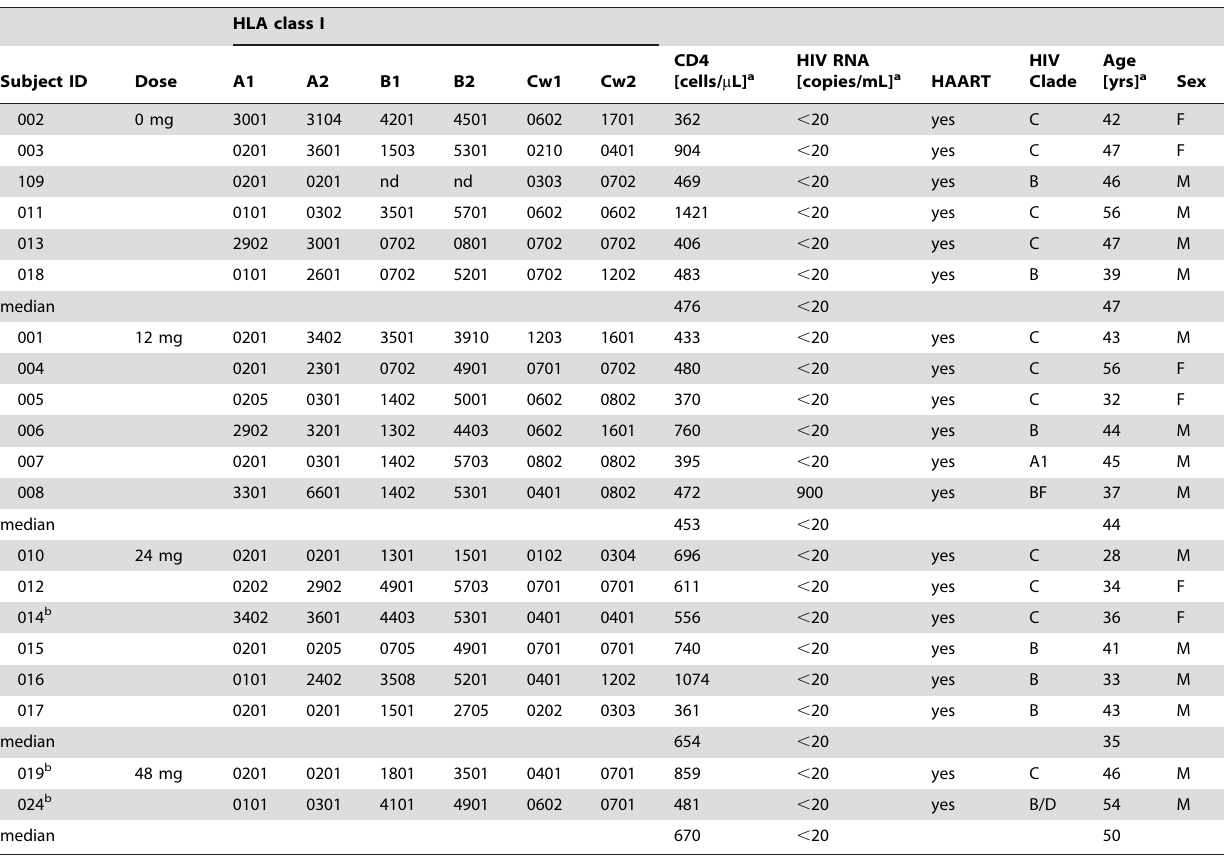
HIV-1 seropositive subjects under HAART treatment used for ‘Opal-HIV-Gag(c)’ vaccine